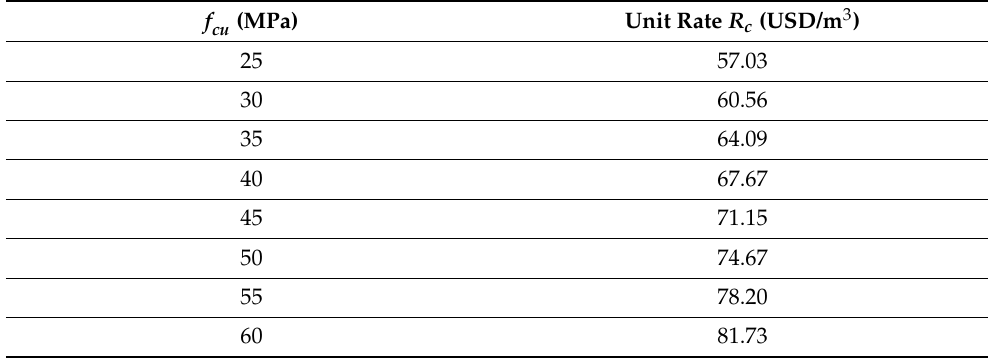
Table 4. Compressive strength f cu variants.